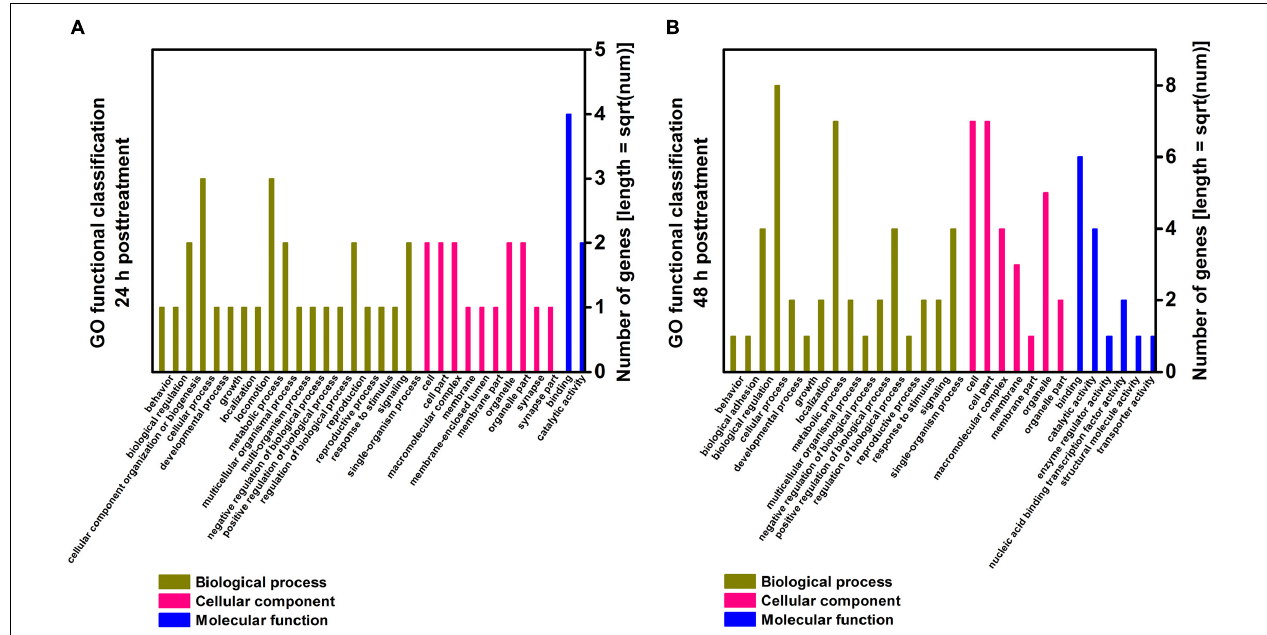
FIGURE 3 | Gene ontology (GO) enrichment analysis of differentially expressed genes in T. cinnabarinus after scopoletin or solvent treatment. (A) Functional categories of differentially expressed genes at 24 h posttreatment. (B) Functional categories of differentially expressed genes at 48 h posttreatment. Three main categories, biological process, cellular component and molecular function, are